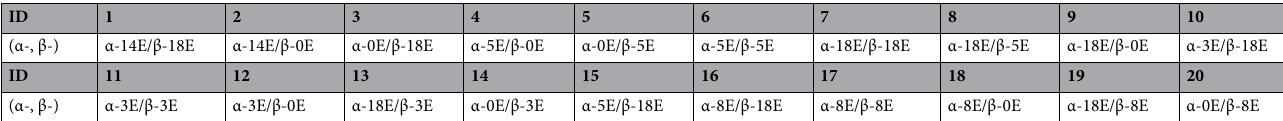
Table 1. The combination of number of glutamate residues added to α- and β-tubulins in our simulation.